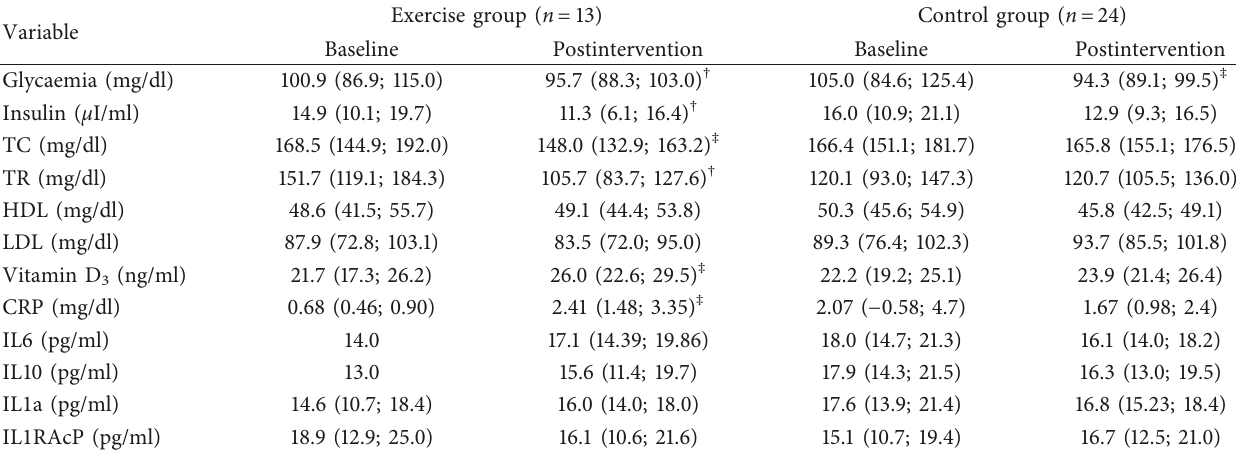
Table 3: Comparison of metabolic and inflammatory variables between baseline and postintervention moments.